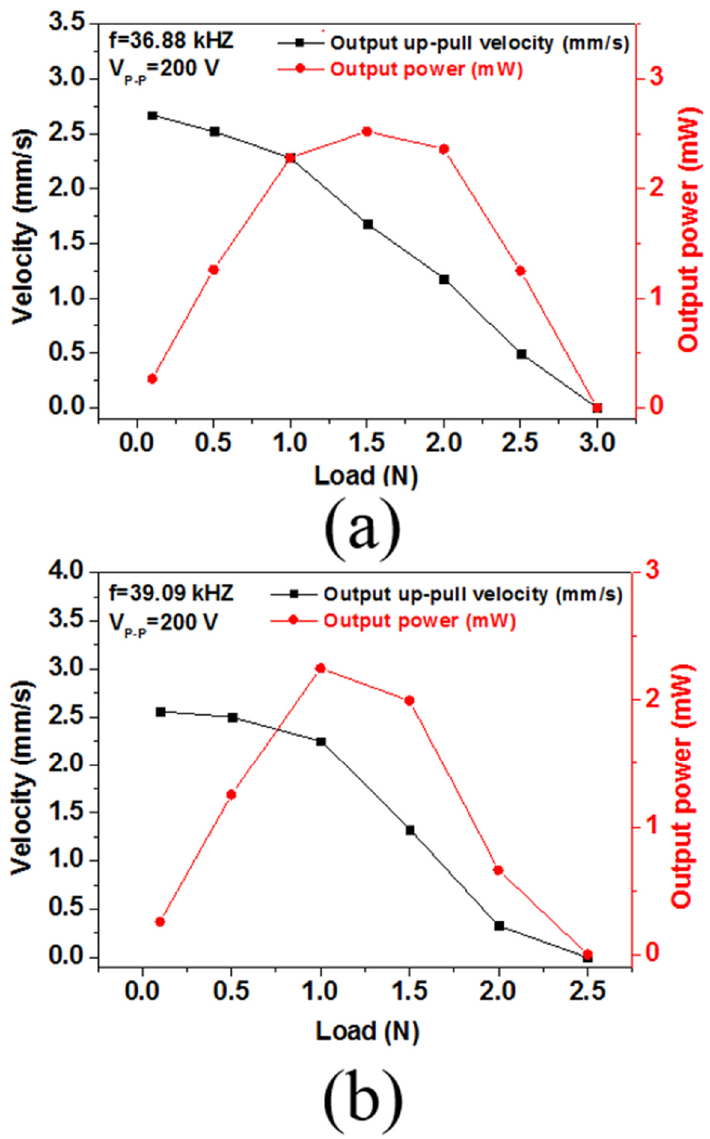
Figure 12. The relationship between the upward speed, force and output power for ( a ) PZT-4 and ( b ) BCTSH + Mn piezoelectric motors. The amplitude of the two–phase driving voltage was measured at their driving frequencies.